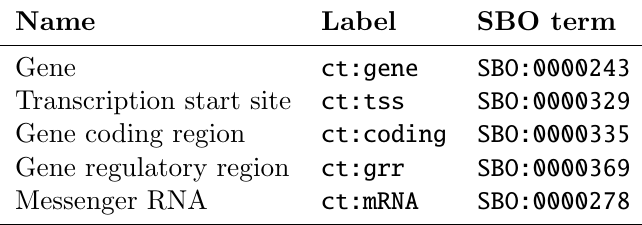
Table 2.3: A sample of values from the conceptual types vocabulary (Section